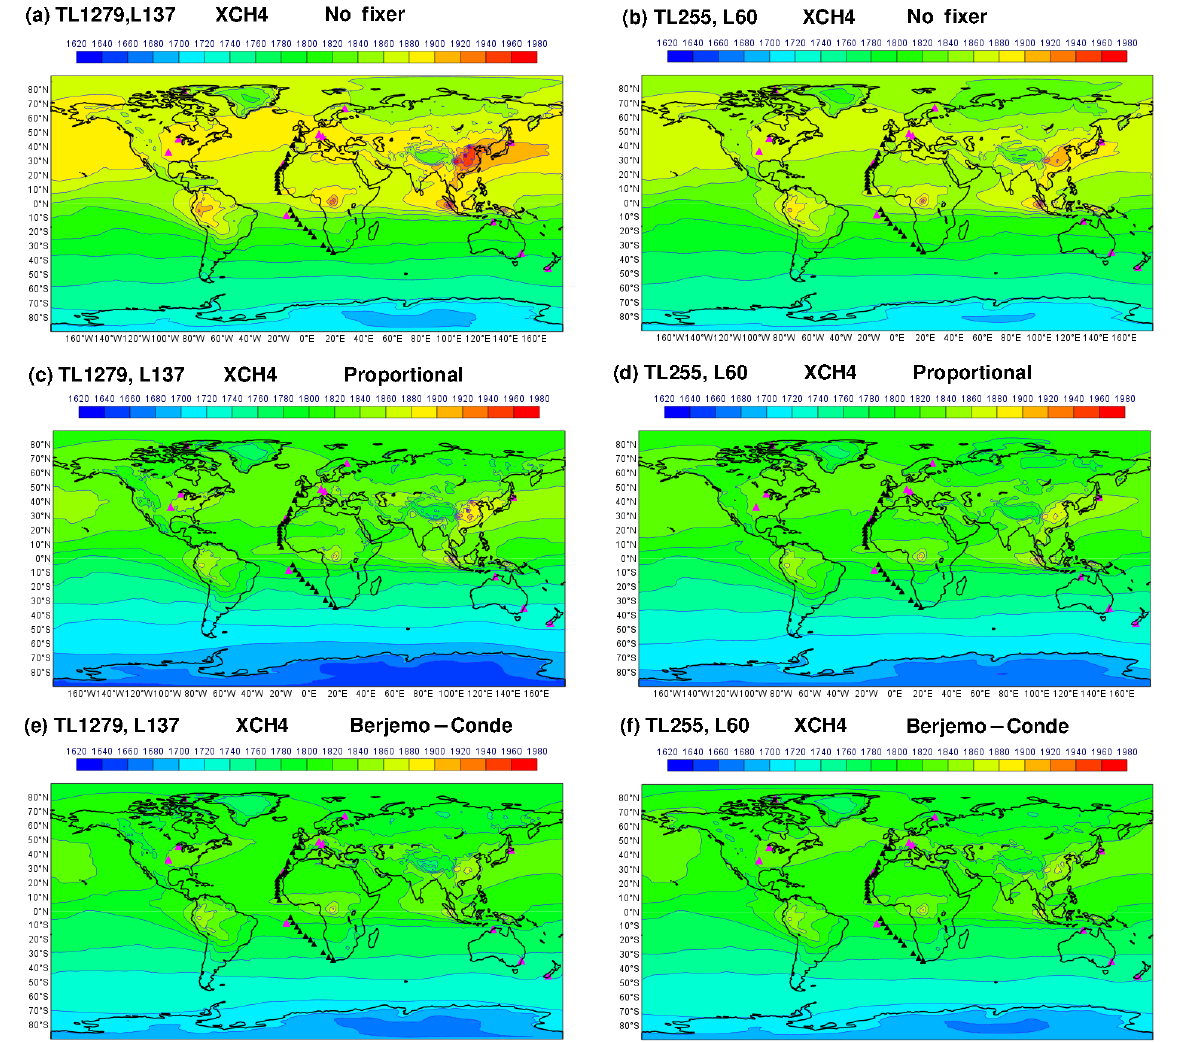
Figure 4. Mean XCH 4 (ppb) from 7 March to 10 April 2014 for the high-resolution (left panels) and low-resolution (right panels) simulations. The effect of the different mass fixers is shown in the different rows. Details of the simulations can be found in Table 1. The pink and black triangles mark the location of the reference observations from TCCON and Polarstern cruise respectively. See Table 2 for a list of the TCCON site